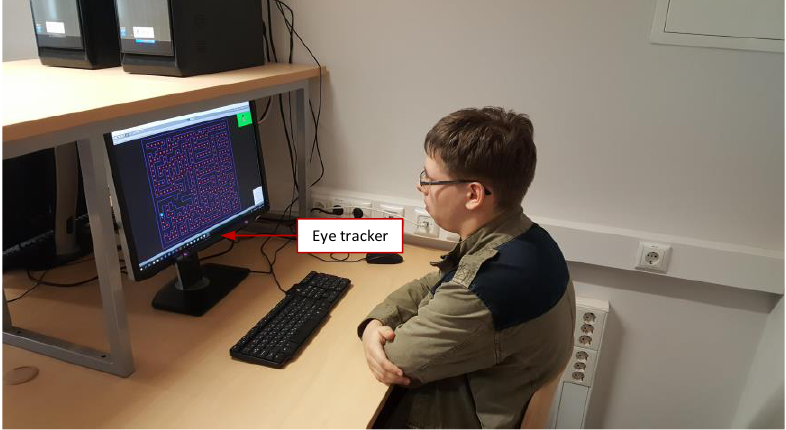
Figure 7. Subject during experiments.